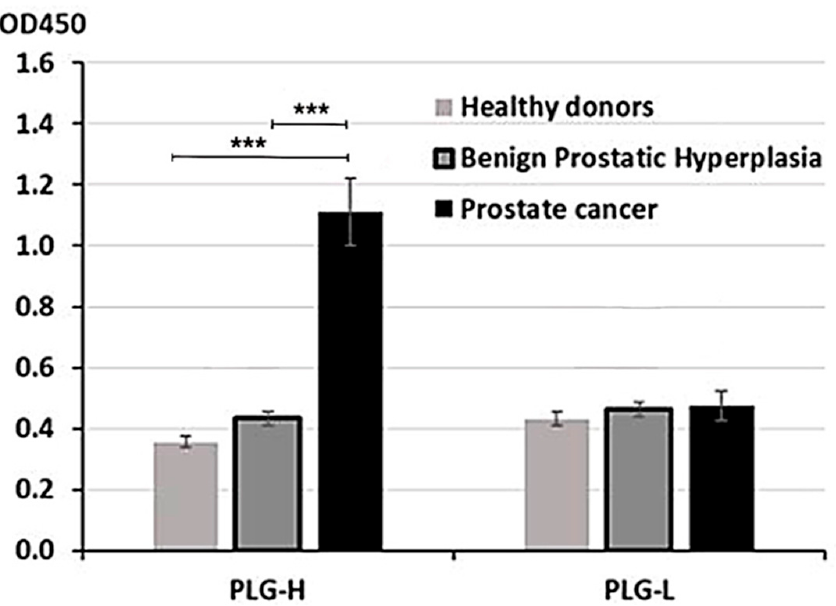
Figure 1. ELISA analysis with PLG-H or PLG-L coated plates. Serum samples from PC, BPH, and healthy donors were incubated in 96-well plates coated with either PLG-H or PLG-L and IgG binding was measured by HRP-conjugated anti-IgG Abs. The experiment was repeated 3 times. *** p < 0.0001, not indicated–not